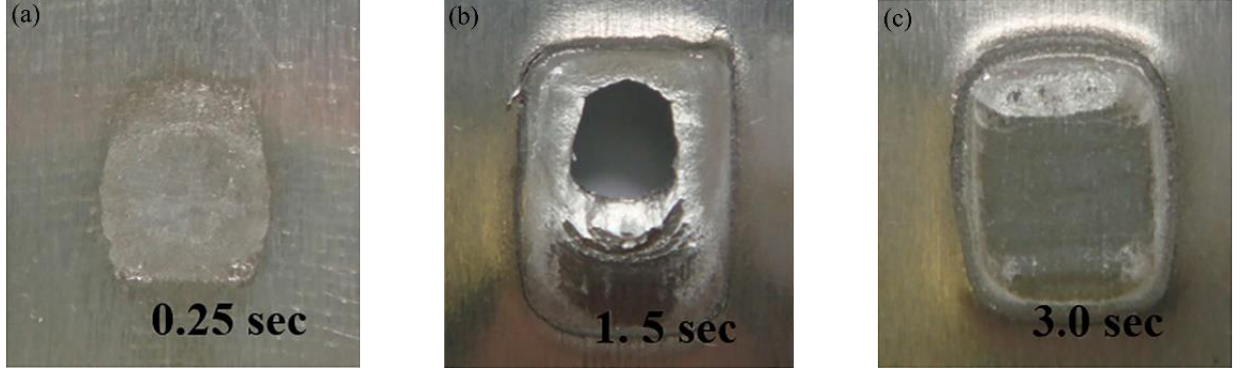
Figure 21. The fracture surface of the aluminum side between aluminum alloy and DC04 steel with increasing welding times [32]: ( a ) 0.25 s; ( b ) 1.5 s; ( c ) 3.0 s.